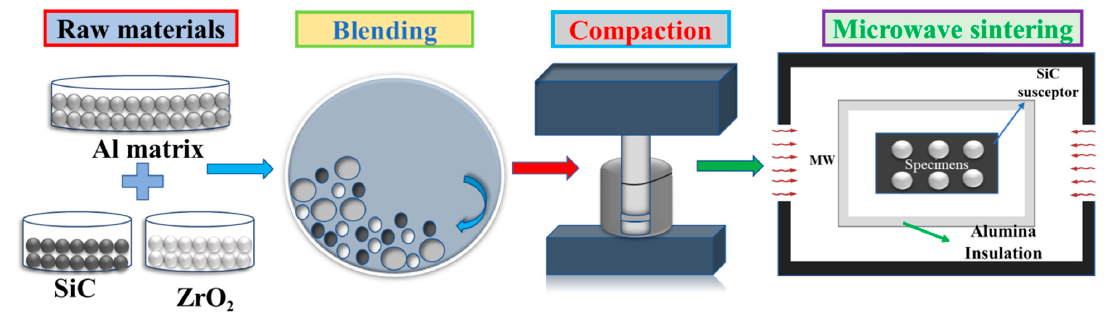
Figure 1. Schematic representation of the development of Al-SiC-ZrO 2